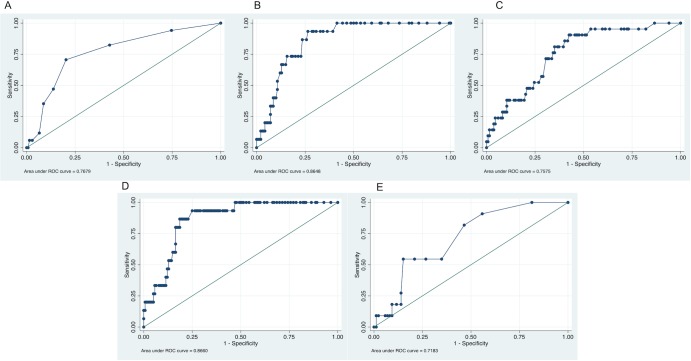
ROC curves for the different original algorithms.Areas under the curve (AUC)-values (95% CI) are 0.7679 (95% CI 0.64768 to 0.88812), 0.864 (95% CI 0.79675 to 0.93278), 0.7575 (95% CI 0.65784 to 0.85708), 0.8660 (95% CI 0.79428 to 0.93772), and 0.7183 (95% CI 0.57795 to 0.85862) for SCORE (A), CUORE (B), FRS (C), QRSIK2 (D), and RRS (E), respectively.